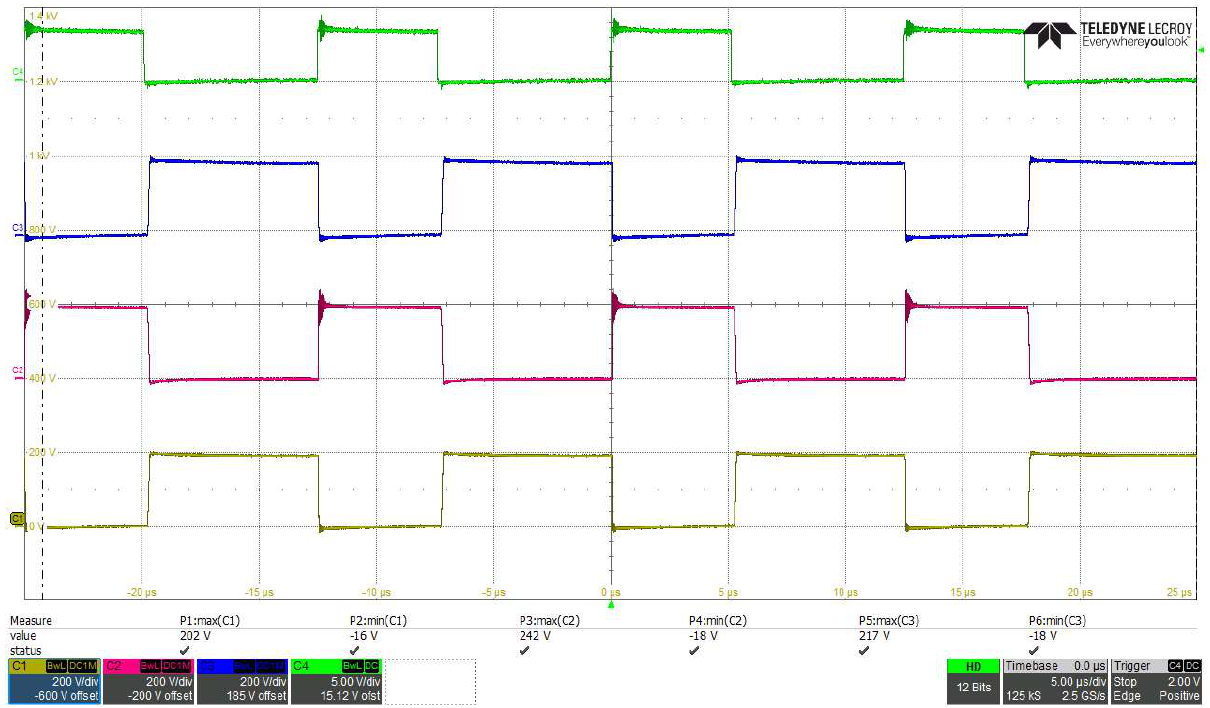
Figure 26. Experimental BHSC waveforms for step-down operation at V H = 300 V, V L = 80 V, and I L = 10 A (controlled). C1: V S3 ; C2: V S4 ; C3: V S5 ; C4: PWM driving signal.